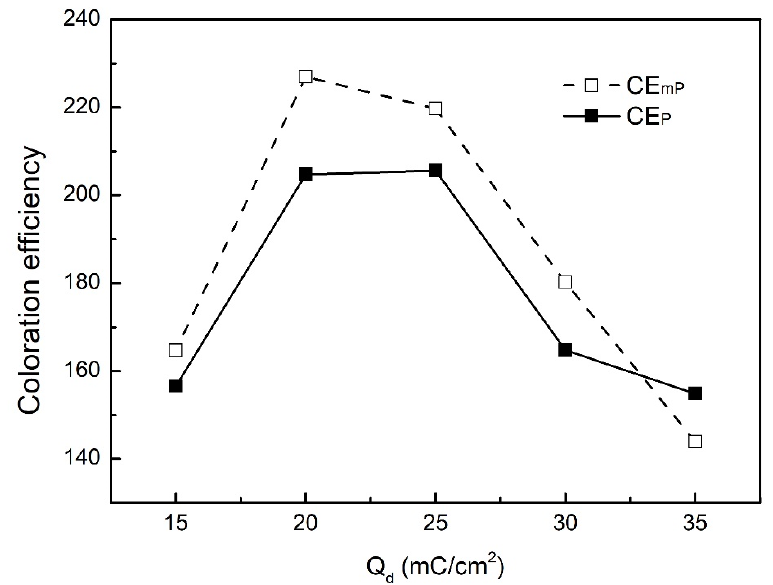
Figure 7. Comparison of the coloration efficiency of the mPEDOT and PEDOT thin films prepared using different Q d ’s.